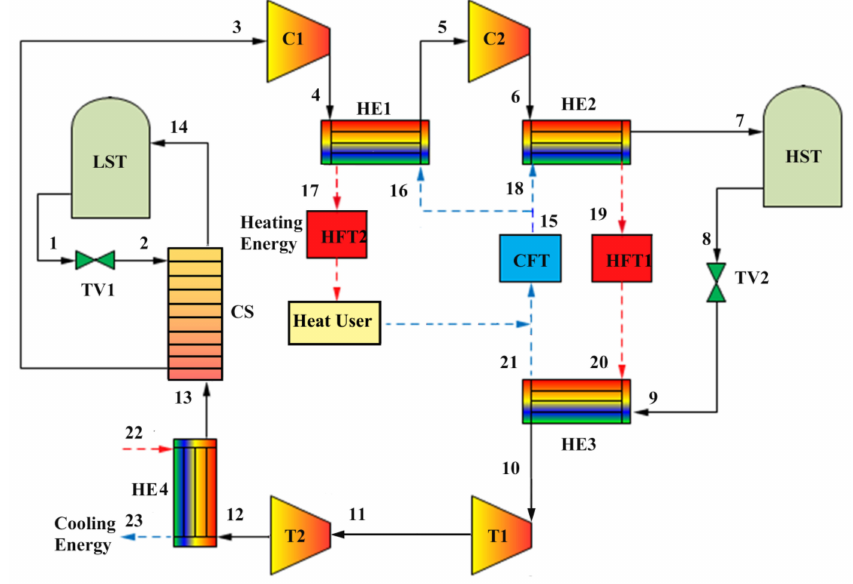
Figure 1. Schematic of the CCES-based CCHP